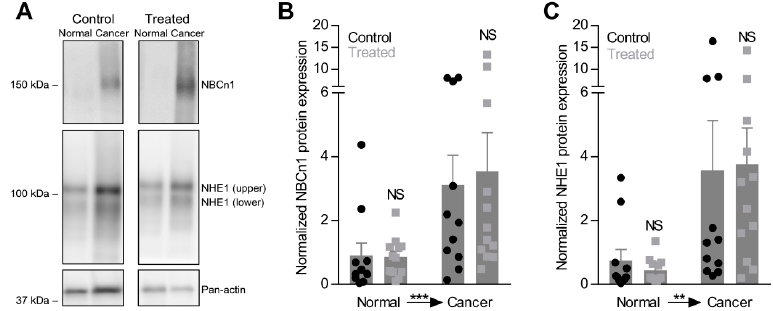
Figure 5. NBCn1 and NHE1 protein expression is increased in organoids from breast cancer tissue compared to normal breast tissue, but unaffected by oral NaHCO 3 therapy. ( A–C ) . Representative immunoblots ( A ) and quantified protein expression levels for NBCn1 ( B ) and NHE1 ( C ) in breast cancer tissue and normal breast tissue from NaHCO 3 -treated mice and control mice ( n = 11–12). Equal amounts of total protein were loaded in each lane of the gels. The band densities for NBCn1 and NHE1 are normalized to that of pan-actin. Data were compared by repeated measures two-way ANOVA followed by Bonferroni post-tests. ** p < 0.01, *** p < 0.001. NS: not significantly different vs. Control. The Full uncropped images of immunoblots please find in Figure S4.